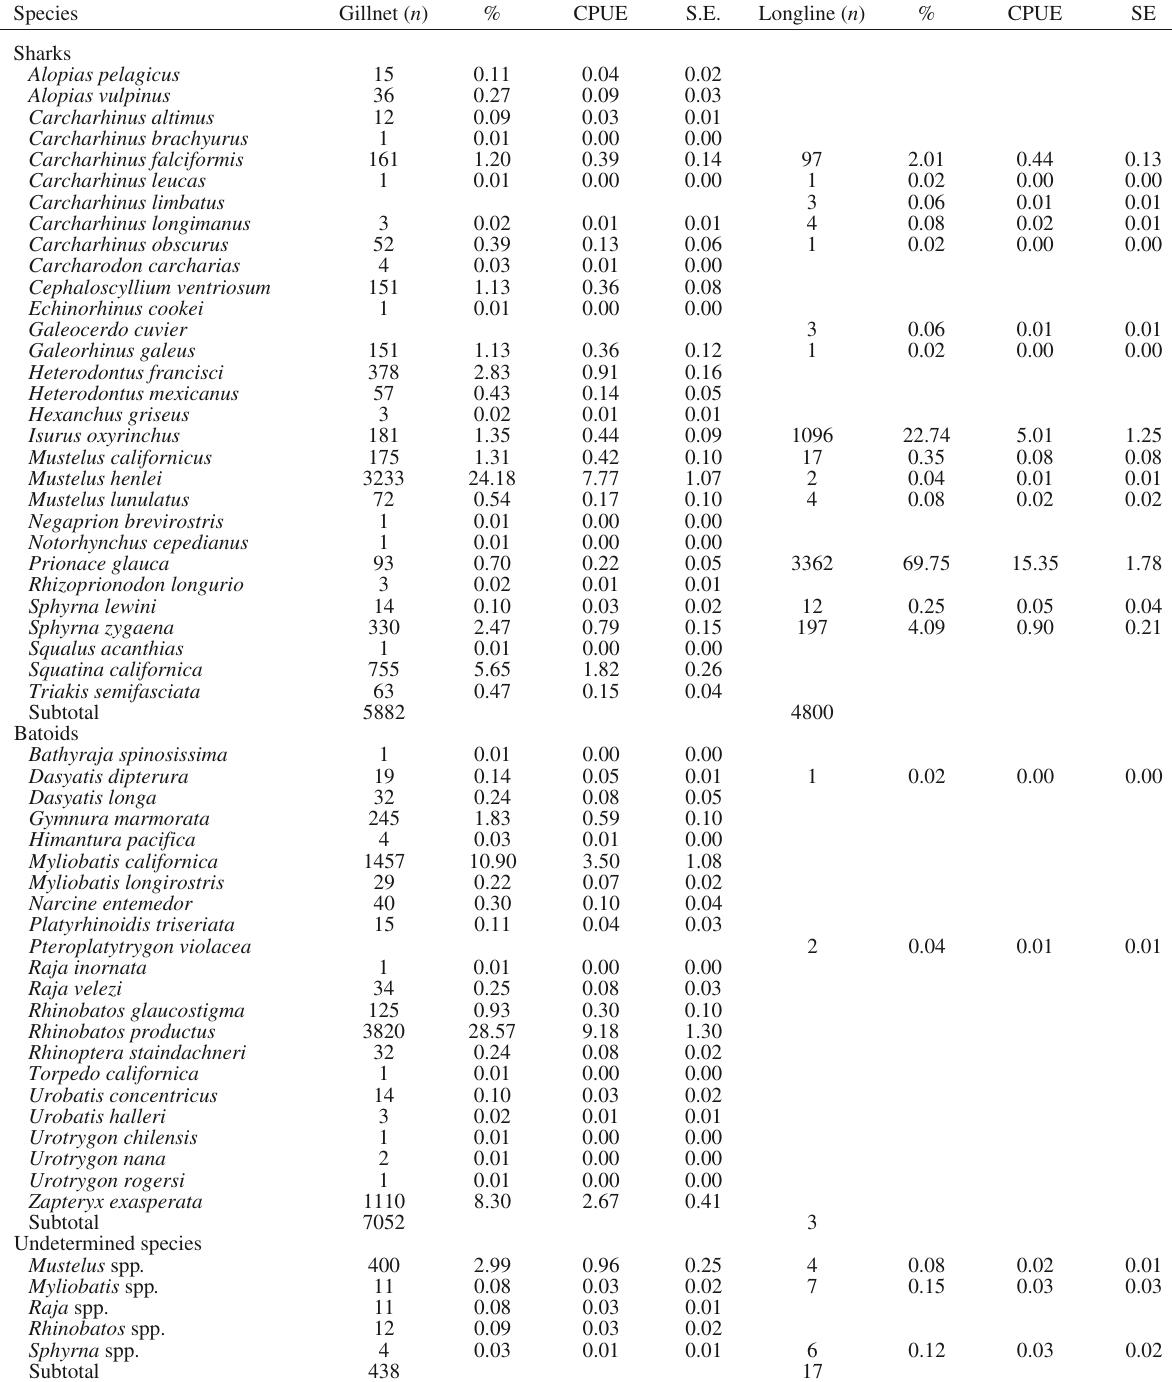
Table 4. – List of elasmobranchs collected in Baja California Sur from 2000 to 2010, according to the fishing gear. The number of individu- als documented ( n ), their percentage contribution on the total catch (%), and the catch per unit effort (CPUE) with standard error (SE) are indicated.